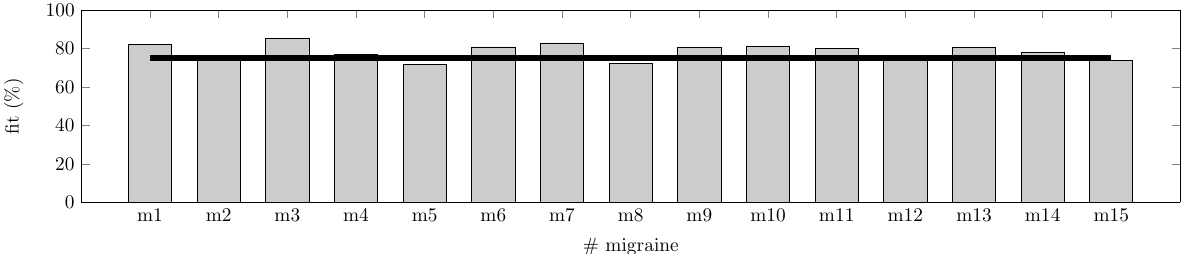
Figure 5. Fit for 15 randomly-chosen migraines and the average after training them with the N4SID algorithm and 30 min of a future